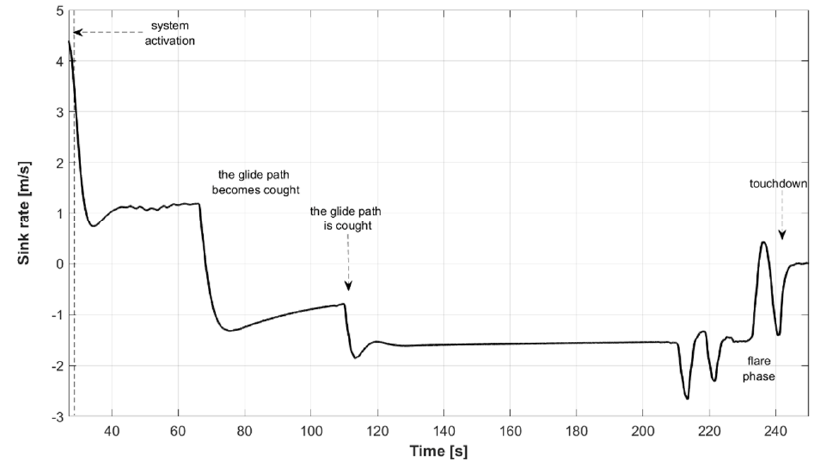
Figure 22. The vertical speed (sink rate) during landing.